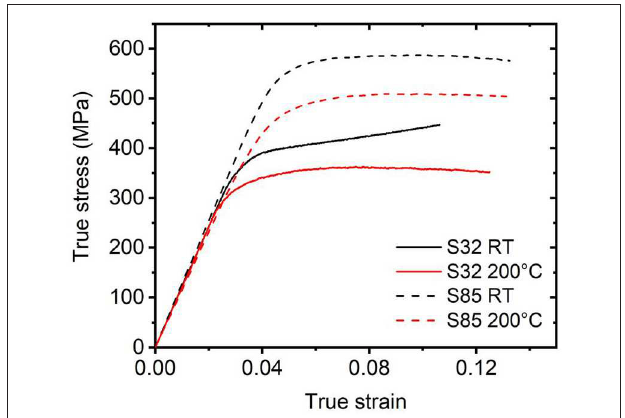
FIGURE 3 | True stress—true strain curves for S32 and S85 alloys tested in compression at room temperature and 200 ◦